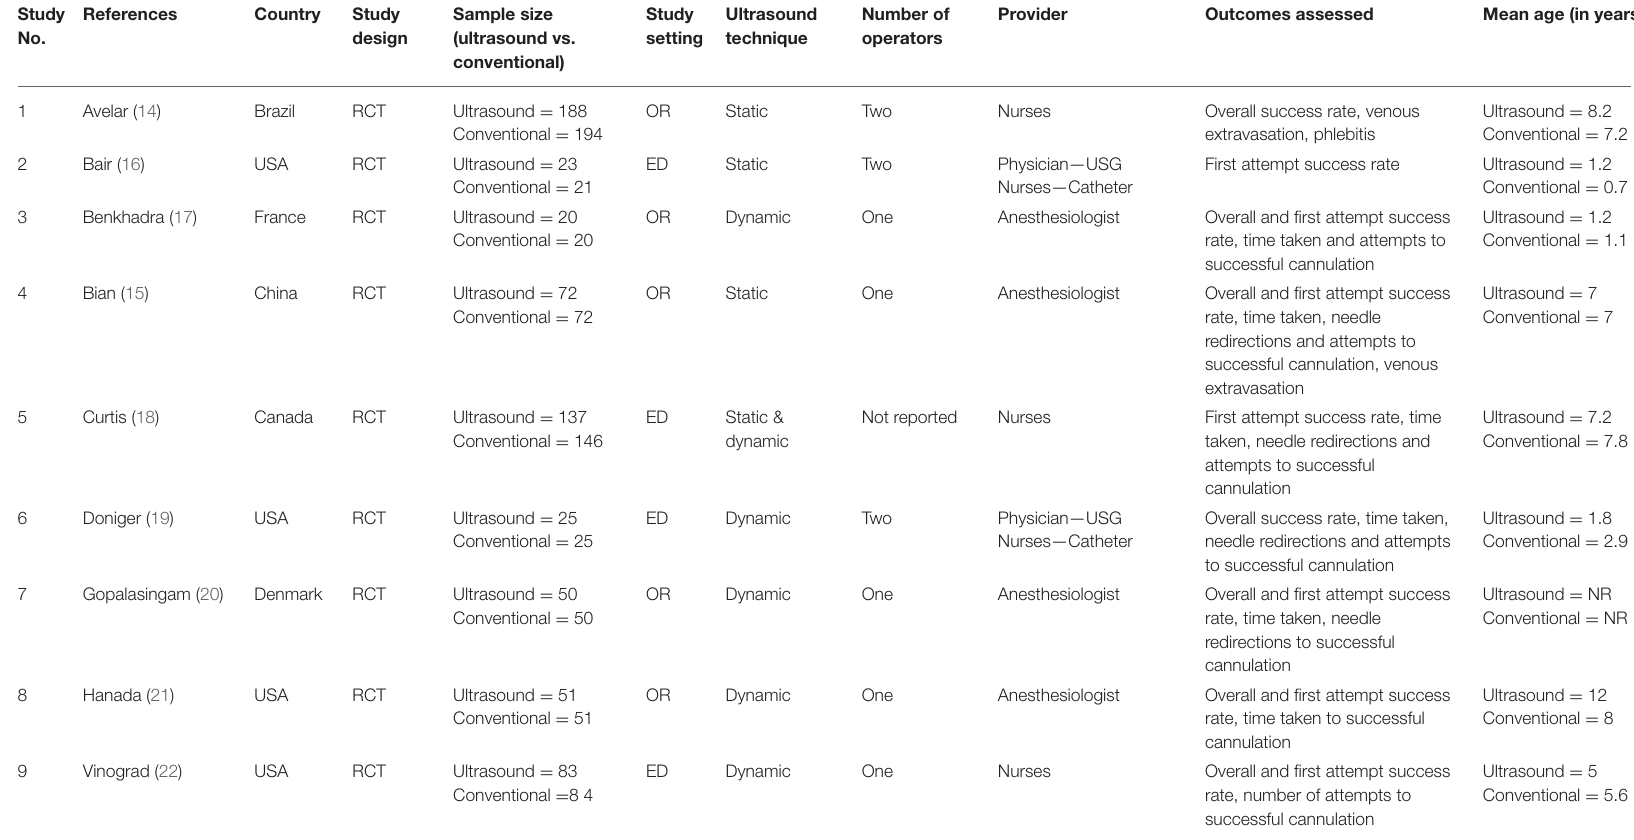
TABLE 1 | Characteristics of the included studies ( N = 9). Study